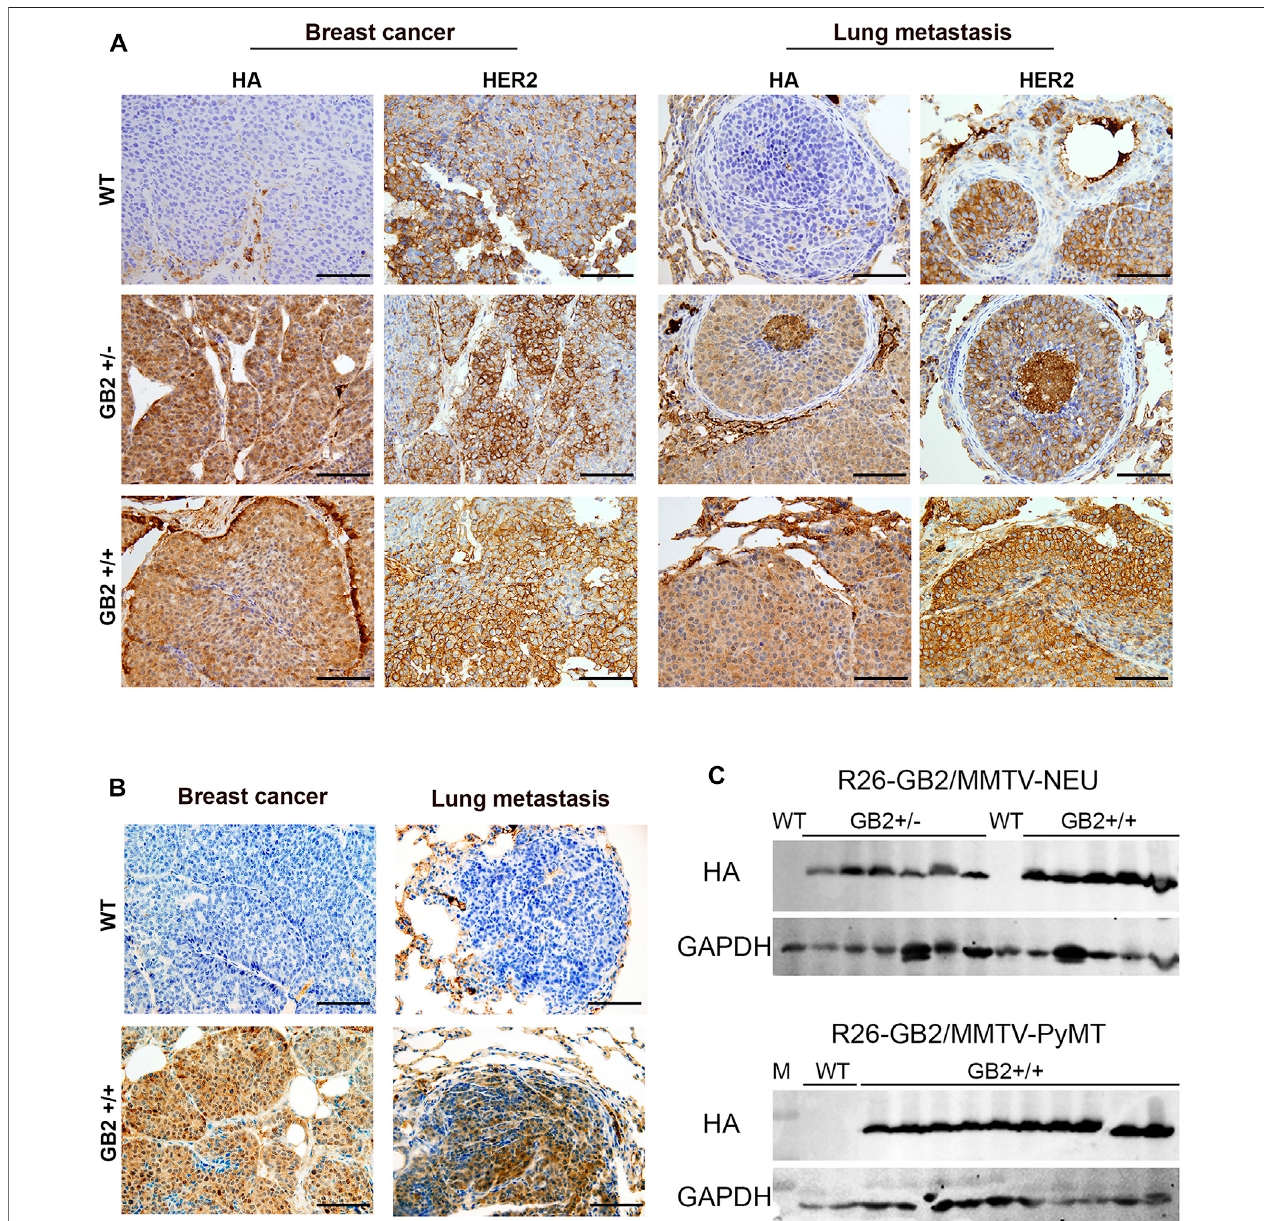
FIGURE5 | GSDMB2-HA expression in primary breast carcinomasand corresponding lung metastasis from R26-GB2/MMTV-NEU model and R26-GB2/MMTV- PyMT mice. (A) Representative images of the GSDMB2-HA and HER2 immunohistochemical expression in primary tumors and metastatic foci from WT, GB2+/- and GB2+/+ GB2/MMTV-NEU mice of 15 months age. (B) Representative images of the GSDMB2-HA staining from GB2+/+ and WT GB2/MMTV-NEU mice of 15 weeks age.Scalebar,100 µm. (C) ComparisonofGSDMB2-HAexpression betweentumorsfromthetwomodelsbyWesternblot.GAPDHwasusedasloadingcontrol.